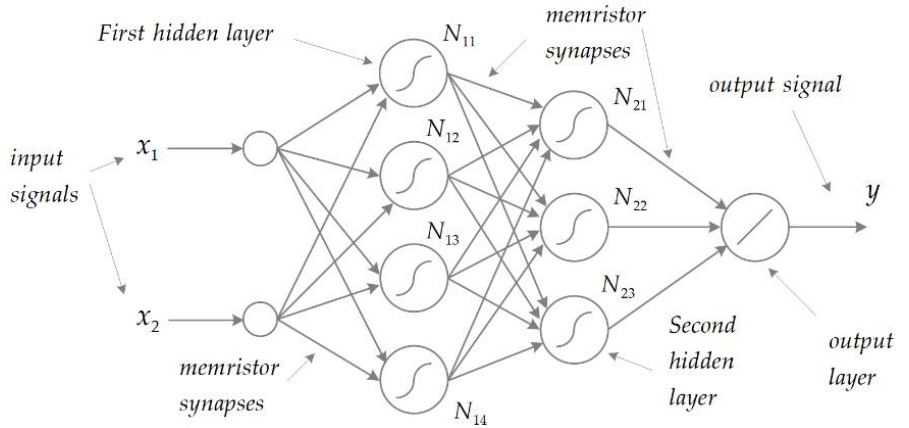
Figure 7. A memristor-based neural network.